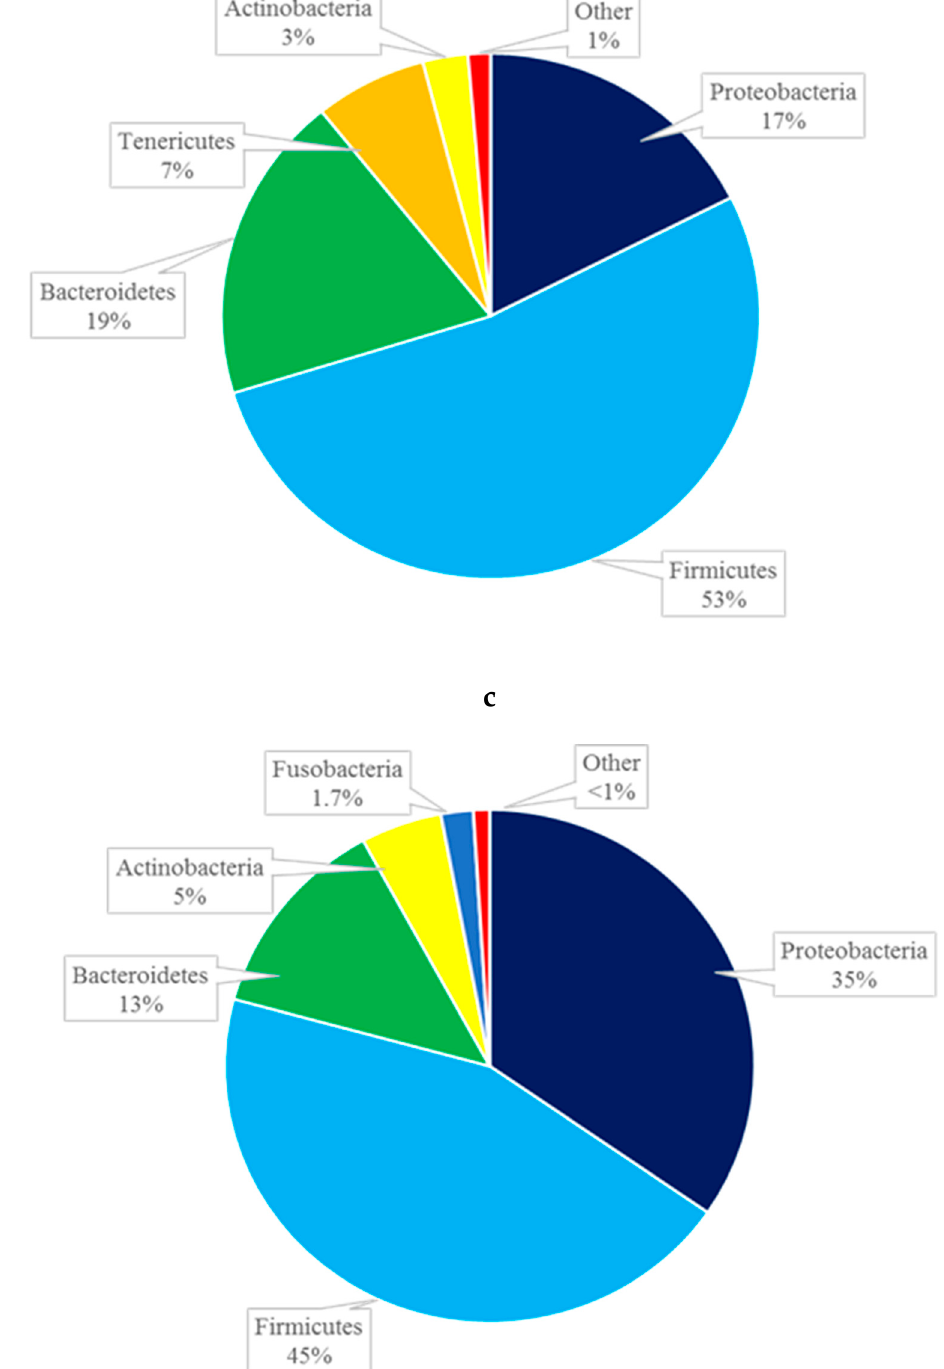
Figure 2. Composition of the microbiome by phylum of the conjunctiva ( a ), eyelid margin ( b ), and periocular skin ( c ).